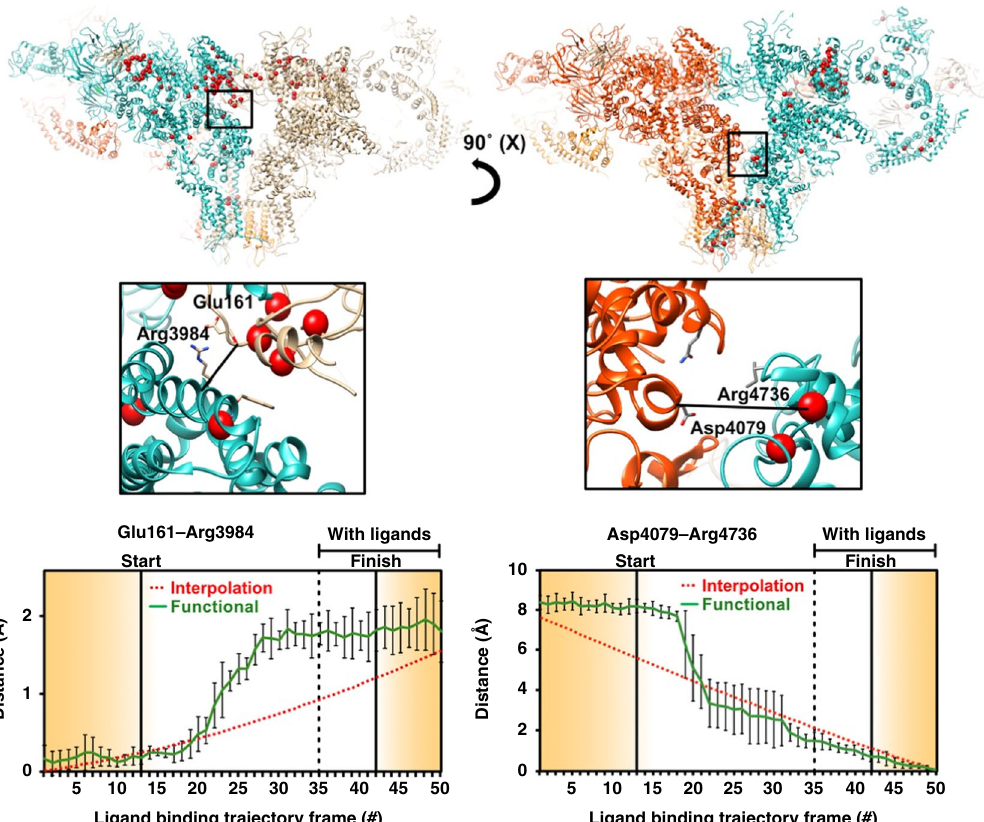
Fig. 5 Conformational changes at interprotomer contact sites along the augmented functional path. The monomers are shown in different colors. Red markers highlight known point-mutations involved in malignant hyperthermia-1 and central core disease of muscle. Distance variations are between two amino acid backbones at contact sites between the monomers. The amino acids used for measurement are shown as sticks. Distance variations between carbon-alpha backbone atoms of two opposing residues along the augmented functional path. Error bars represent the full scatter (not standard deviation) of the results obtained with six different starting